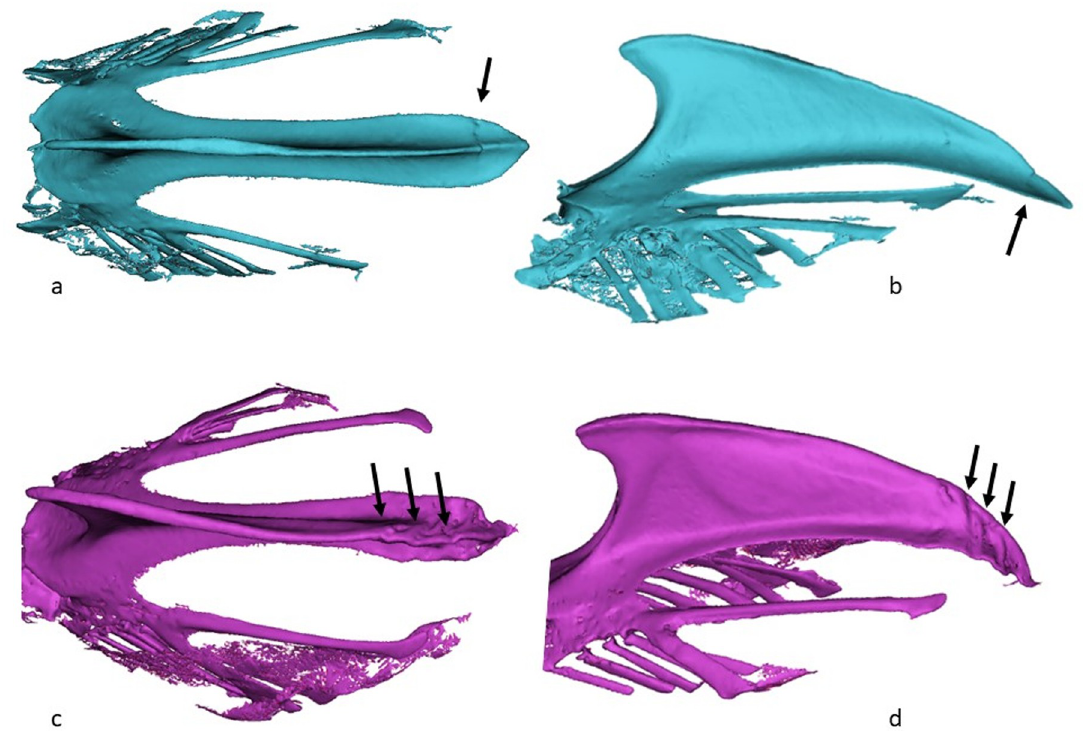
Fig 3. 3D model from CT scanning of keel bones: a,b, frontal and lateral view of the keel bone of a 32-week hen (barn floor) showing one fracture (arrow); c, d, frontal and lateral view the keel bone of a 85-week hen (cages) showing minimum three fracture (arrows).